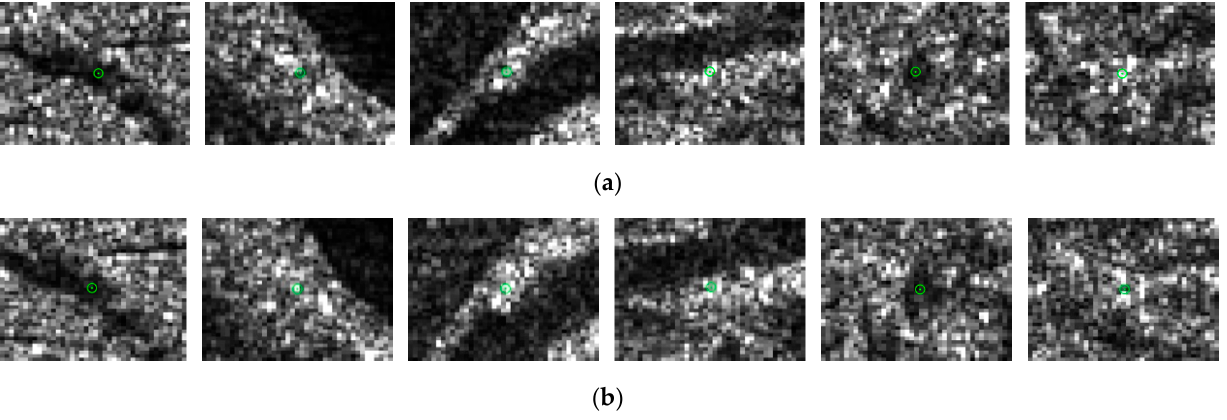
Figure 13. Comparison of six pairs of randomly selected tie-points between strips and their SAR images, where ( a ) is the master image and ( b ) is the slave image.